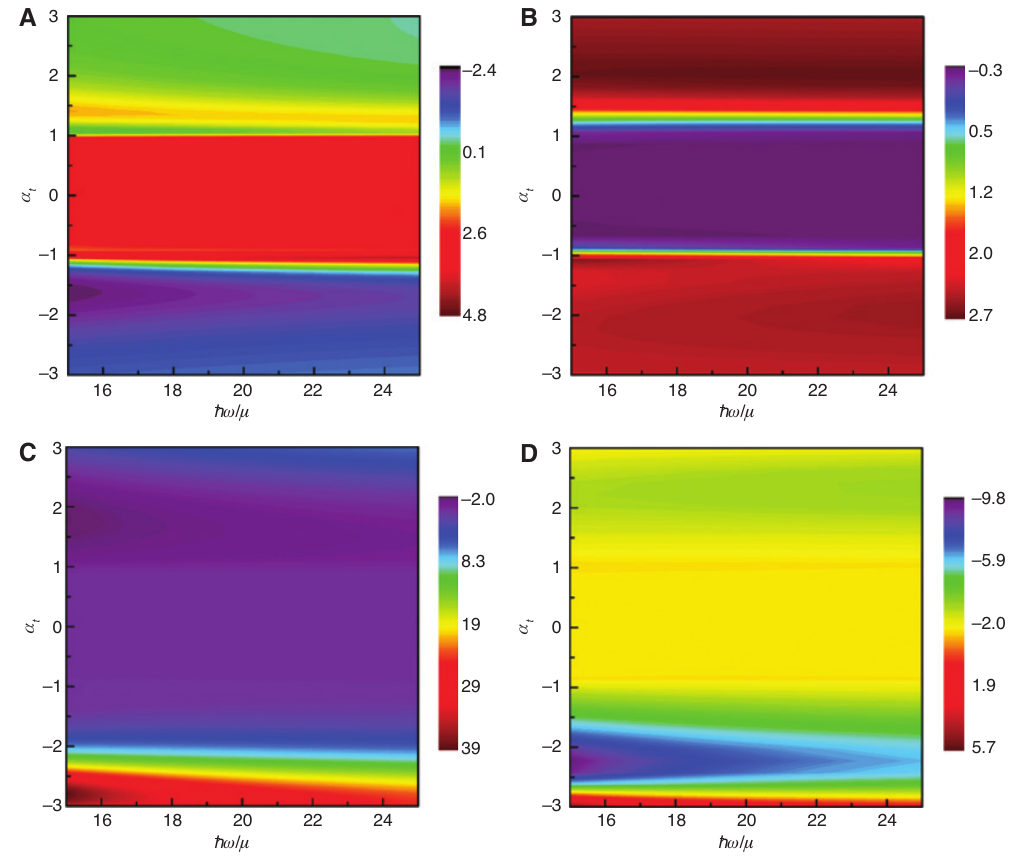
and ħ ω / μ on the photonic spin Hall shifts. t